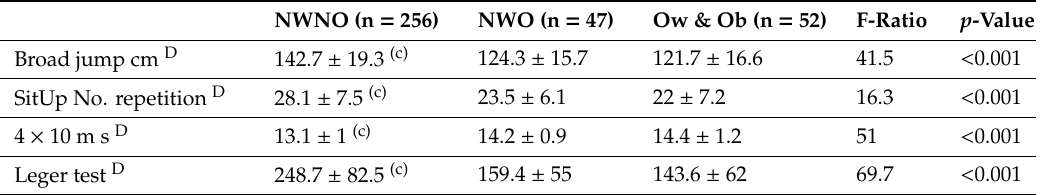
Table 4. Main e ff ect in physical fitness between the three defined groups of